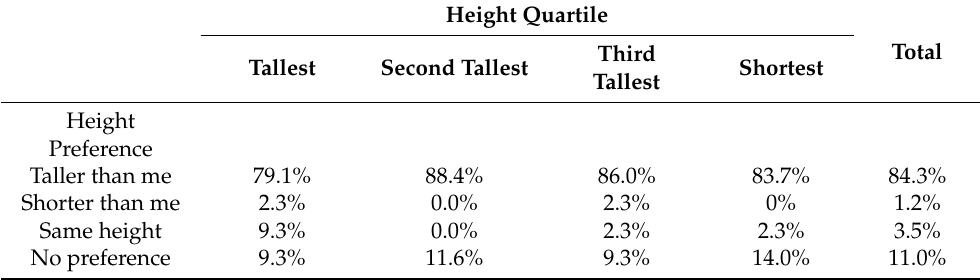
Table 3. Cross-tabulations of height preference for romantic partners across height